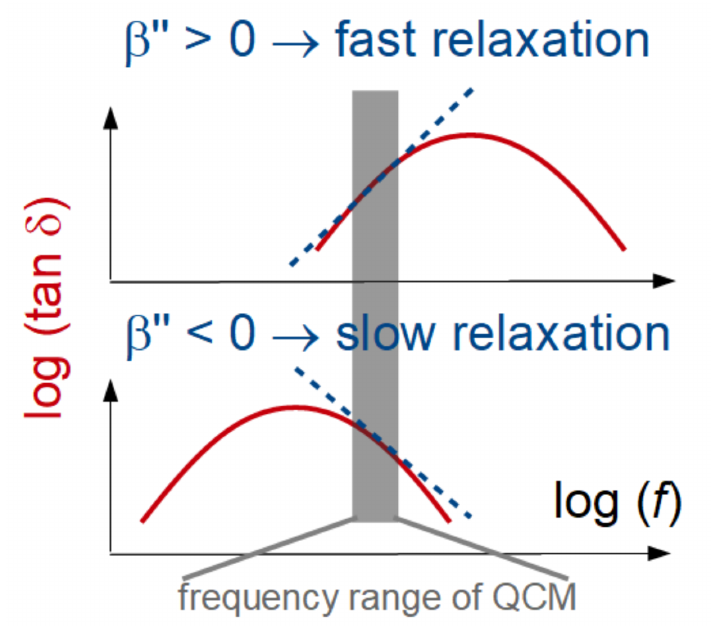
Figure 10. Viscoelastic spectra (red lines) and their approximation with power laws in a limited frequency range (dashed lines). The sign of the power law exponent pertaining to tan δ indicates whether the main relaxation is faster or slower than the frequency of the QCM. B” in the legend is the power law exponent of tan δ